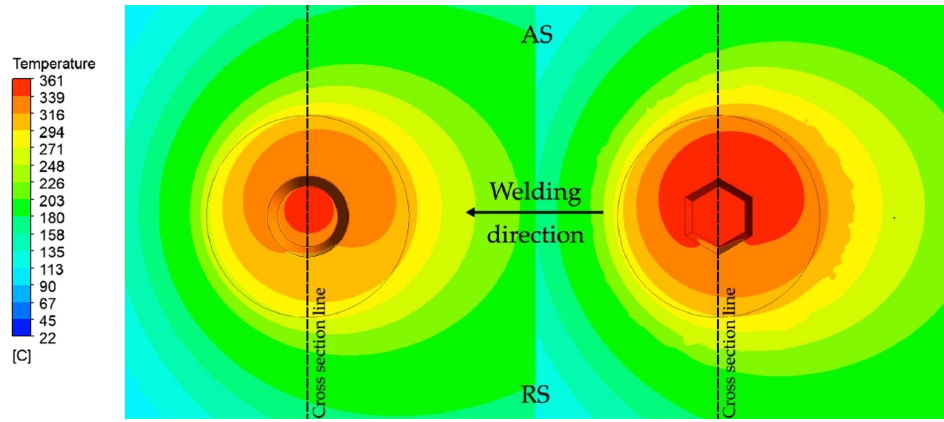
Figure 8. Temperature distribution for both FSW − C ( left ) and FSW − H ( right ), top view.